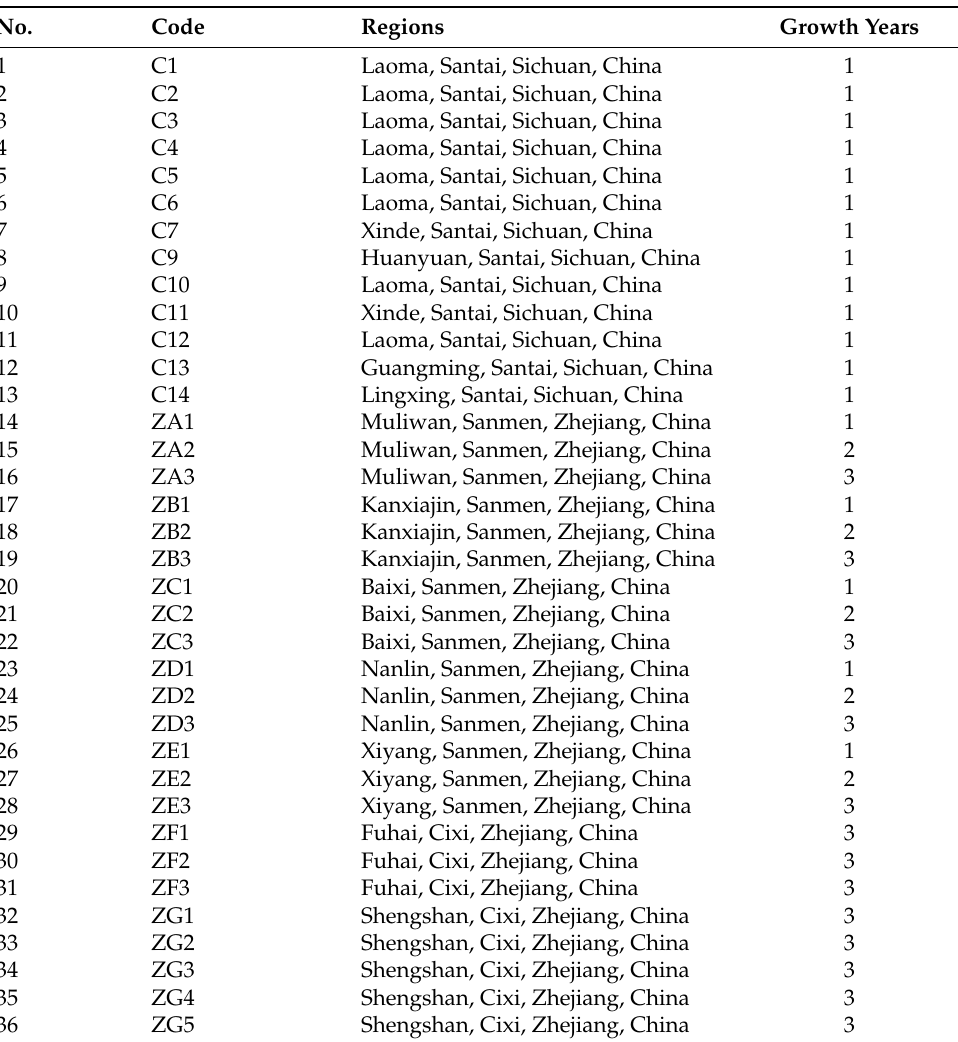
Table 2. Information of Ophiopogonis Radix